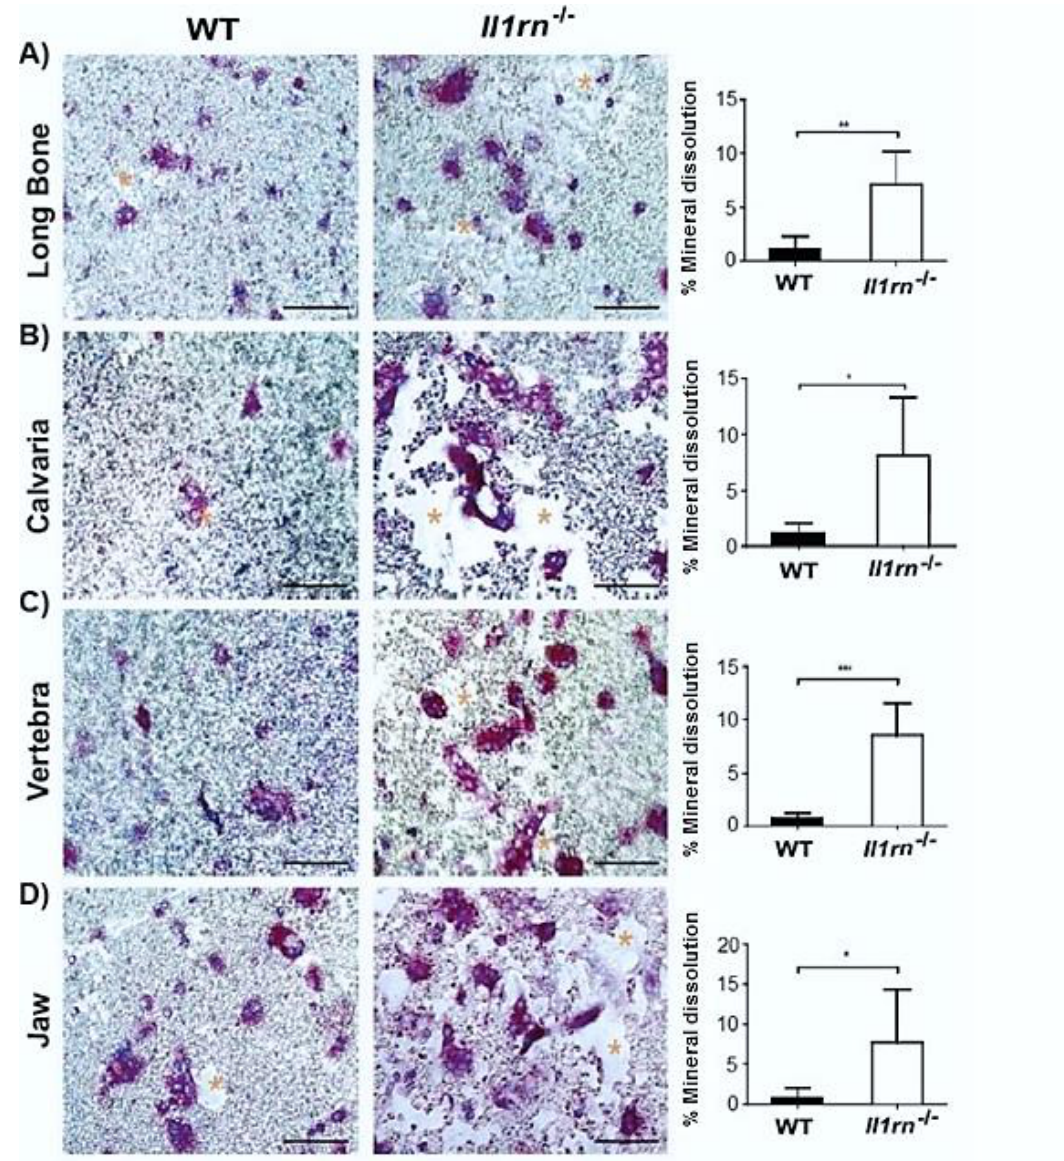
Figure 5. Il1rn − / − osteoclasts show an enhanced mineral dissolution independently of the skeletal site. Absence of IL-1RA increased the in vitro dissolution of the inorganic matrix of bone from all osteoclast precursors irrespective of the isolation site, suggesting that site-specific di ff erences present in vivo can be outweighed in vitro. ( A – D ) Microphotographs of hydroxyapatite-coated plates of which part is dissolved by osteoclasts derived from various skeletal sites in both wild-type (WT) and Il1rn − / − mice. Bone marrow (BM) cells from long bone, calvaria, vertebra, and jaw were cultured with 30 ng / mL M-CSF and 20 ng / mL RANKL on hydroxyapatite-coated plates for 8 days. Osteoclasts were stained by TRAcP (in purple) and nuclei were stained by 4’,6-Diamidino-2-Phenylindole (DAPI) (blue). The dissolved area was labeled by asterisks. Scale bar = 100 µ m. The dissolved area was quantified and compared between WT and Il1rn − / − mice for long bone ( A ), calvaria ( B ), vertebra ( C ) and jaw ( D ) ( n = 6, * p < 0.05, ** p < 0.01, *** p <